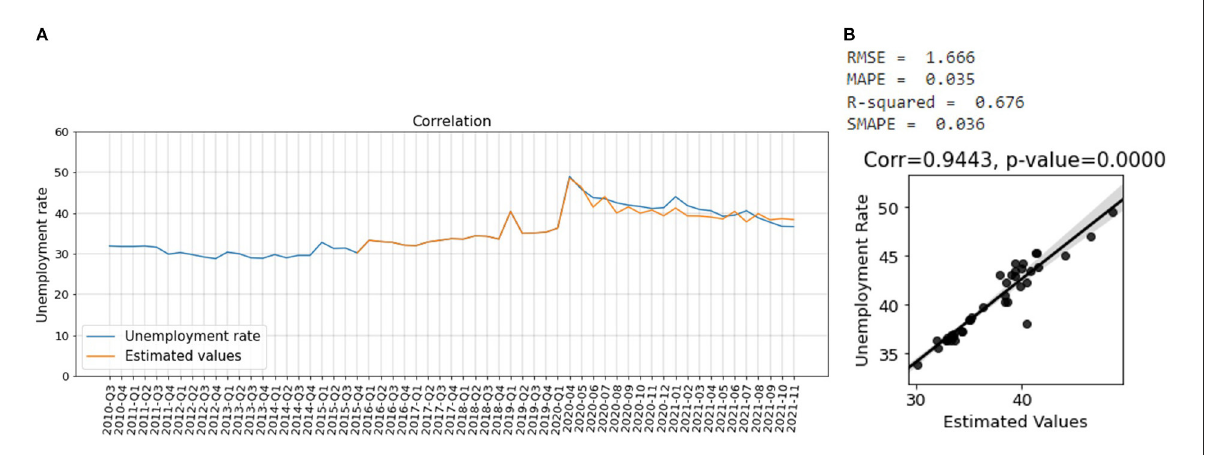
FIGURE10 (A) Estimated values of unemployment rate of Gauteng during COVID-19 pandemic matches the actual unemployment rate, (B) Correlation between the estimated values of the unemployment rate during COVID-19 and the actual unemployment rate for Gauteng province with 95 percentiles.